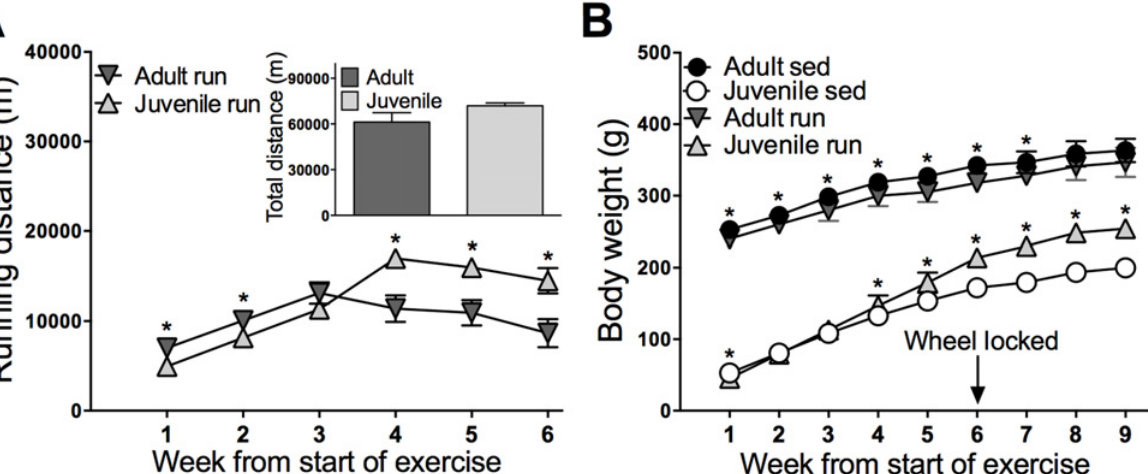
Fig 1. Running distance and body weight. A) Weekly total running distance across six weeks of exercise, estimated per rat. Adults ran more in the first half of exercise, whereas juveniles ran more during the second half of exercise, although total distance summed across six weeks did not differ between age groups. B) Body weight across the duration of the experiment; adult runners weighed less than their sedentary counterparts during exercise, then returned to sedentary levels shortly following exercise cessation. Juvenile runners weighed more than their sedentary counterparts toward the end of exercise and continued to weigh more after exercise cessation. Data are represented as mean ± SEM; * p <